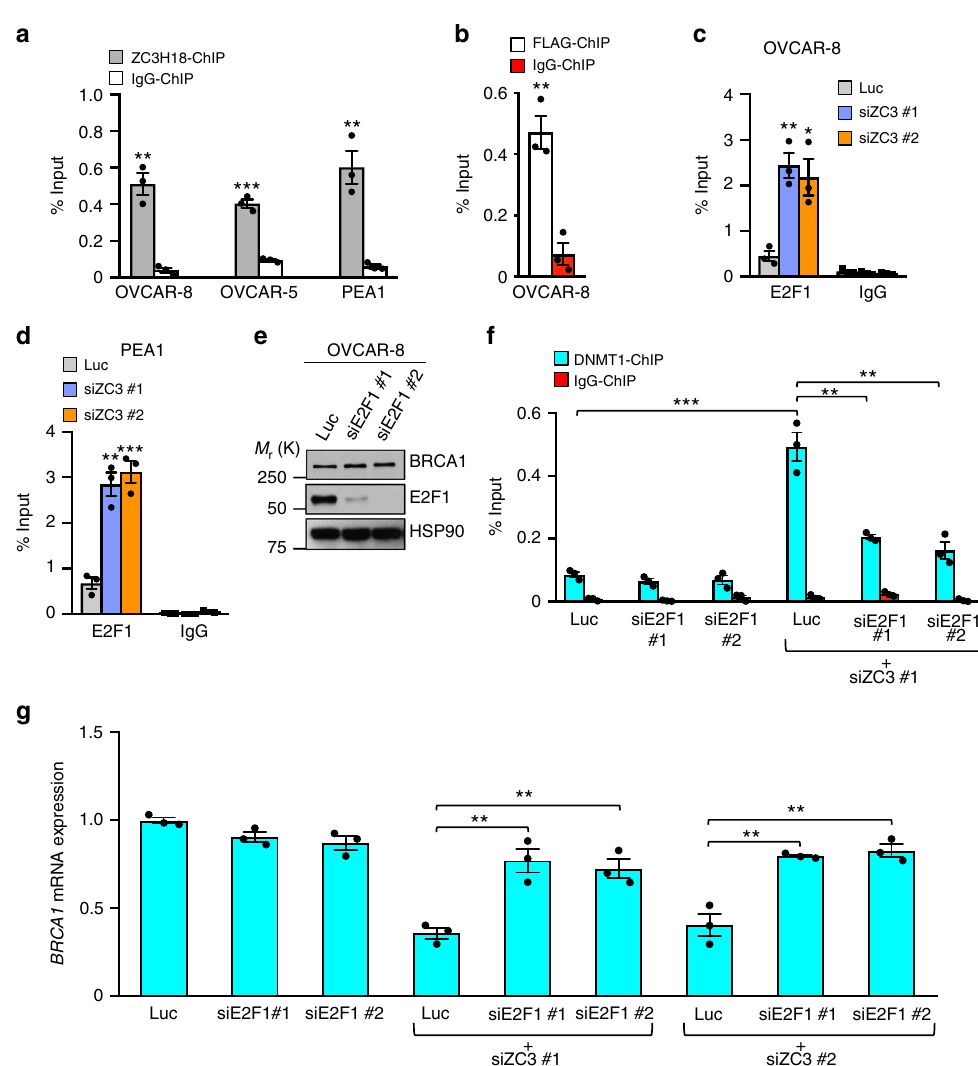
Fig. 4 ZC3H18 occupies the BRCA1 promoter and regulates E2F1. a OVCAR-8, OVCAR-5, and PEA1 cells were processed for ChIP assays using anti-ZC3H18 or IgG control antibodies and primers speci fi c for the BRCA1 promoter. b OVCAR-8 cells transiently expressing SFB-ZC3H18 were processed for ChIP assays using FLAG or IgG control antibodies. c , d ChIP assays showing increased occupancy of E2F1 on the BRCA1 promoter when ZC3H18 is depleted. OVCAR-8 ( c ) and PEA1 ( d ) cells transfected with control luciferase (Luc) or ZC3H18 siRNAs (siZC3) were processed for ChIP using anti-E2F1 or IgG control antibodies 48 h after transfection. e E2F1 depletion does not affect BRCA1 levels. OVCAR-8 cells were transfected with control luciferase (Luc) or two independent E2F1 siRNAs and analyzed for BRCA1, E2F1, and HSP90 levels by immunoblotting 48 h later. f DNMT1 occupancy on the BRCA1 promoter requires E2F1. OVCAR-8 cells transfected with Luc, E2F1, or ZC3H18 siRNA with our without E2F1 siRNAs were processed for ChIP with DNMT1 or control IgG antibodies 48 h after transfection. g Depletion of E2F1 restores BRCA1 expression when ZC3H18 is depleted. OVCAR-8 cells transfected with Luc, E2F1, or ZC3H18 siRNAs with our without E2F1 siRNAs were analyzed for BRCA1 mRNA levels by qRT-PCR. BRCA1 mRNA levels were normalized to GAPDH mRNA levels. Data in a – g are means± SEM from three independent experiments. ** p < 0.01, *** p < 0.001, unpaired Student ’ s t- test. Representative immunoblots in e are provided from three independent experiments. Unprocessed blots are provided in Source data fi